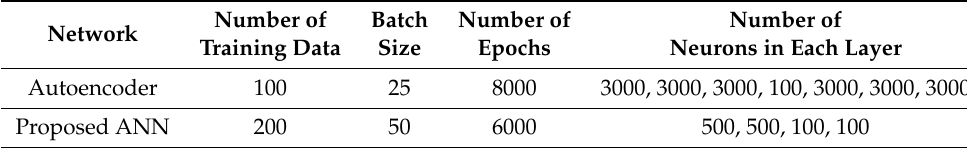
Table 4. Hyperparameters of the surrogate